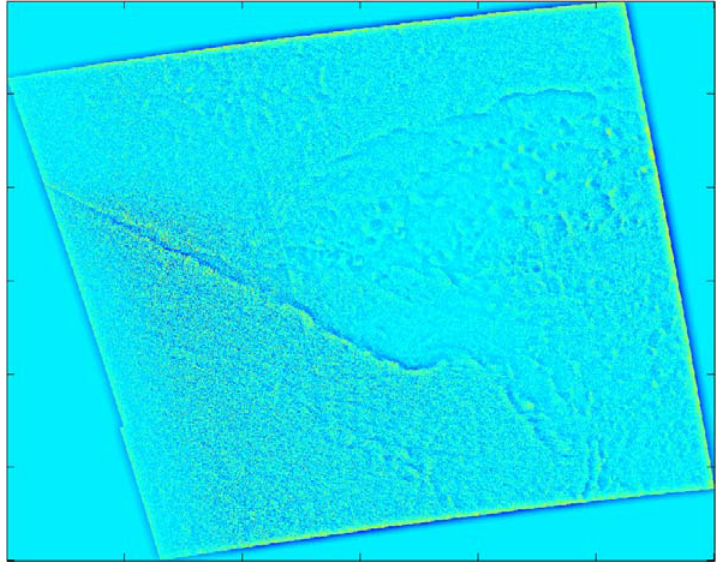
Figure 5. High-pass Gaussian filtered SDWS image for the case study, 0533 UTC on December 9, 2007. Brighter shades indicate larger wind speeds with green being the